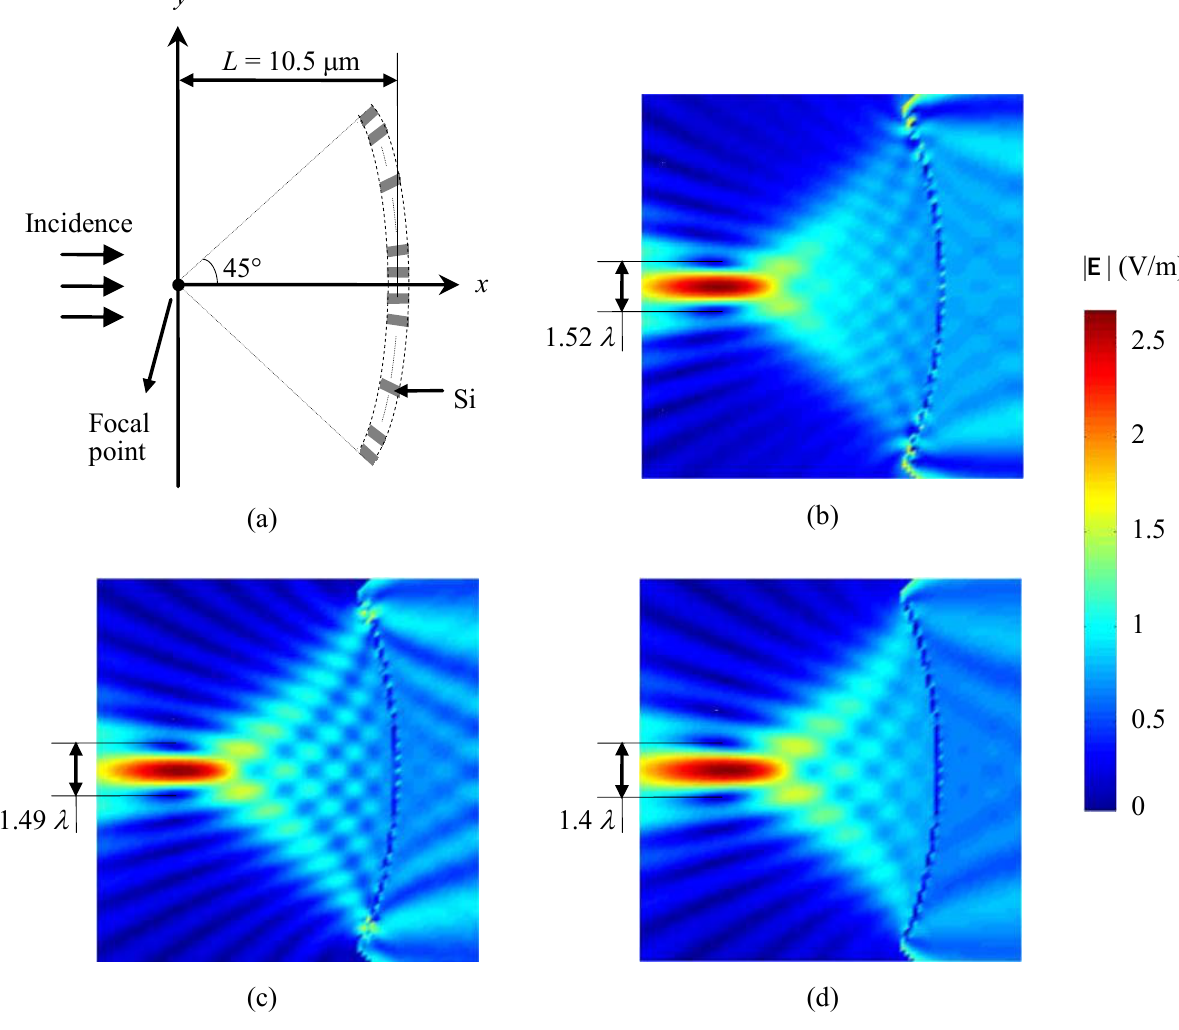
Figure 3. Numerical results for a curved GMR structure: ( a) Schematic rendition of device geometry, (b) Results for wavelength λ = 1.69 μ m, (c) Results for wavelength λ = 1.76 μ m, (d) Results for wavelength λ = 2 μ